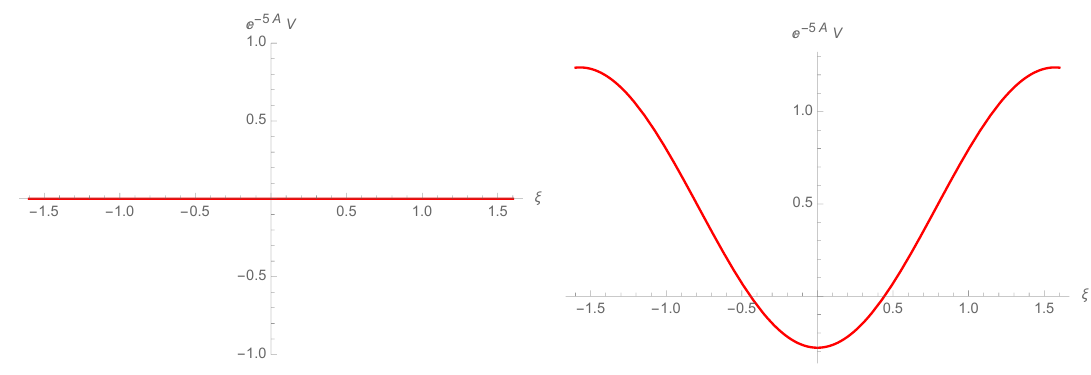
Figure 1 . he probe brane potentials of the supersymmetric and non-supersymmetric (cid:12)xed points at X = 1 and X = 1 = 3 1 = 4 ,